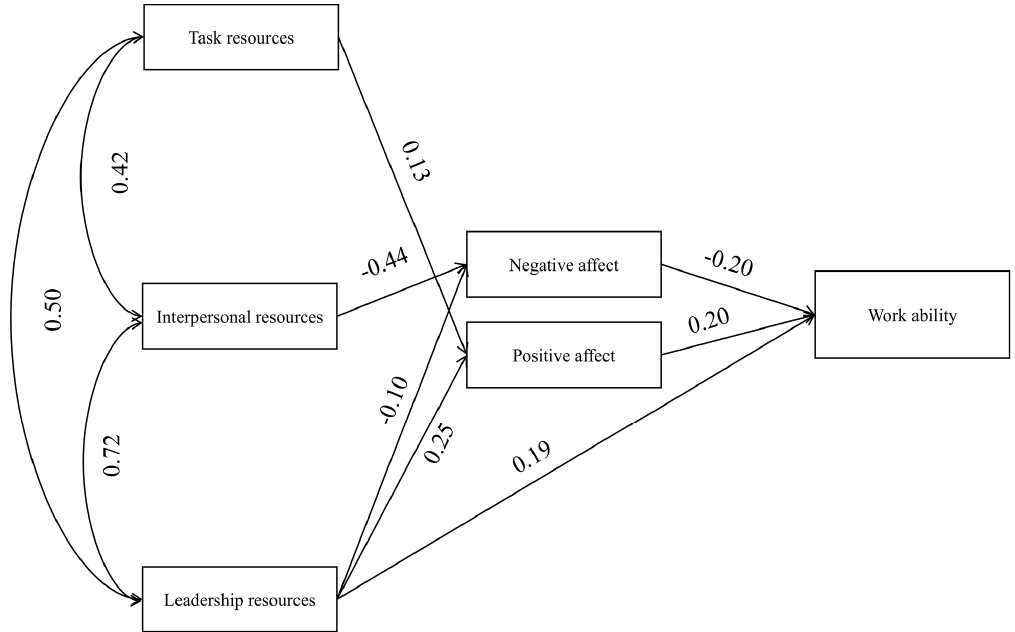
Figure 2. The final model for non-shift workers with standardised significant parameters consistent with the best-fit model.